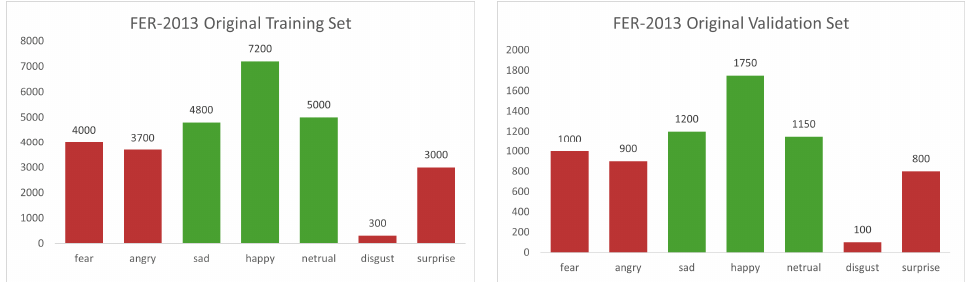
Figure 2. Distribution of classes in the FER-2013 dataset. Graph represents the mean values of green and red bars.